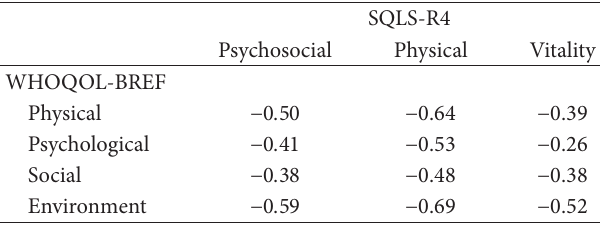
Table 4: Correlations between the SQLS-R4 and the WHOQOL- BREF. SQLS-R4 Psychosocial Physical Vitality WHOQOL-BREF Physical −0.50 −0.64 −0.39 Psychological −0.41 −0.53 −0.26 Social −0.38 −0.48 −0.38 Environment −0.59 −0.69